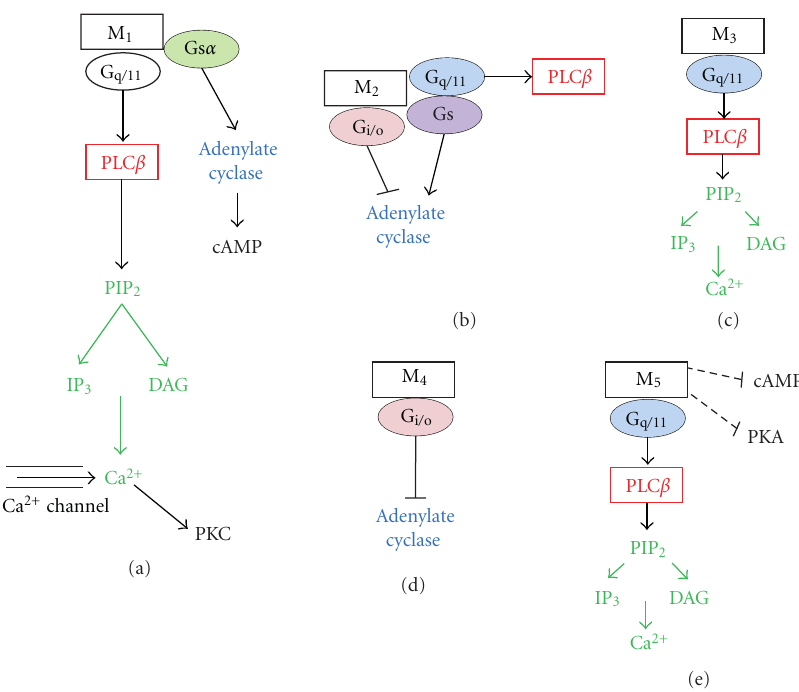
Figure 1: Receptor-specific G-protein coupling and signaling for the five human muscarinic receptors: (a) M 1 , (b) M 2 , (c) M 3 , (d) M 4 , and (e) M 5 .